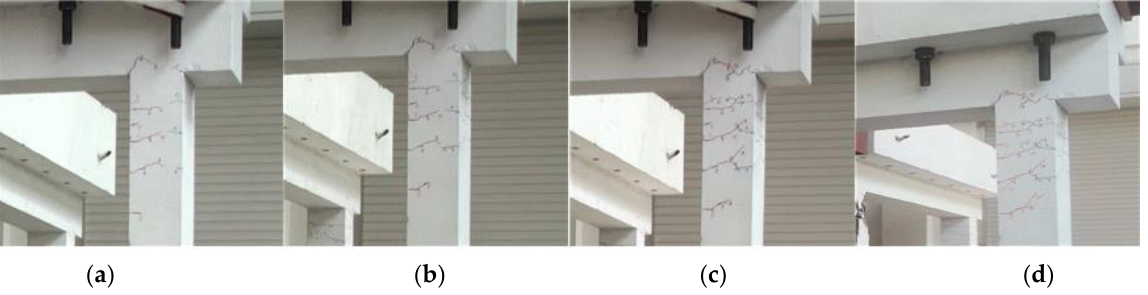
Figure 17. Failure sequence of the RC frame with the WKDS (upper-left corner). ( a ) 8 Cycle (0.40%), ( b ) 12 Cycle (1.00%), ( c ) 14 Cycle (1.56%), ( d ) final.